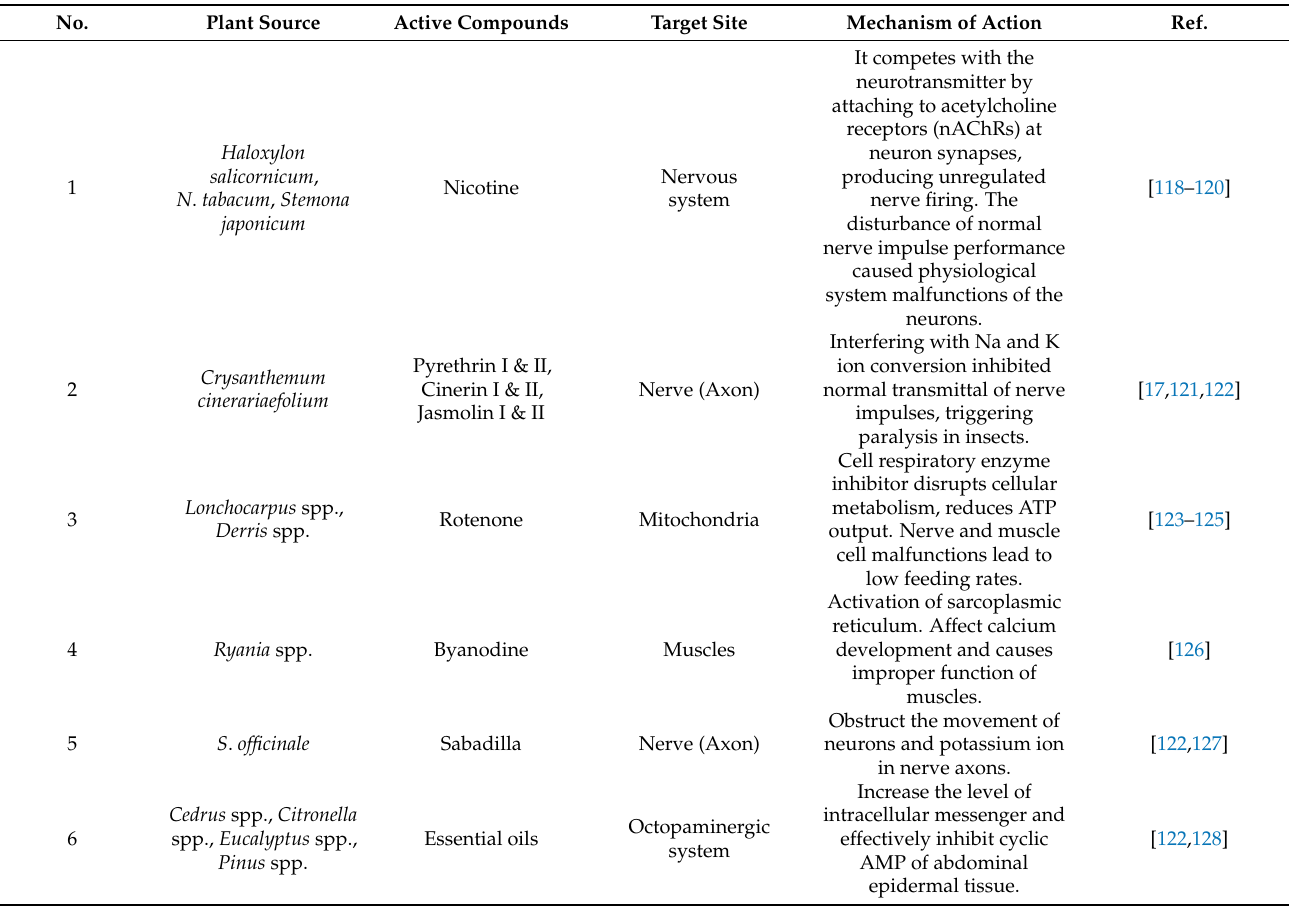
Table 3. Mechanism of action of some